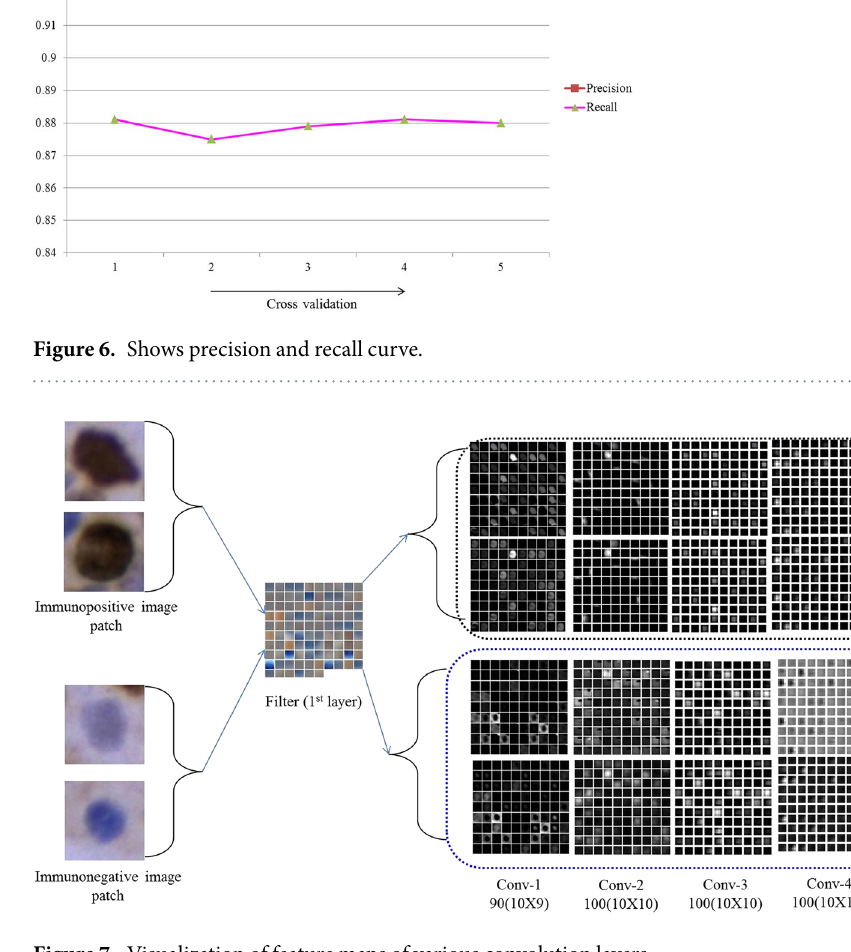
Figure 7. Visualization of feature maps of various convolution